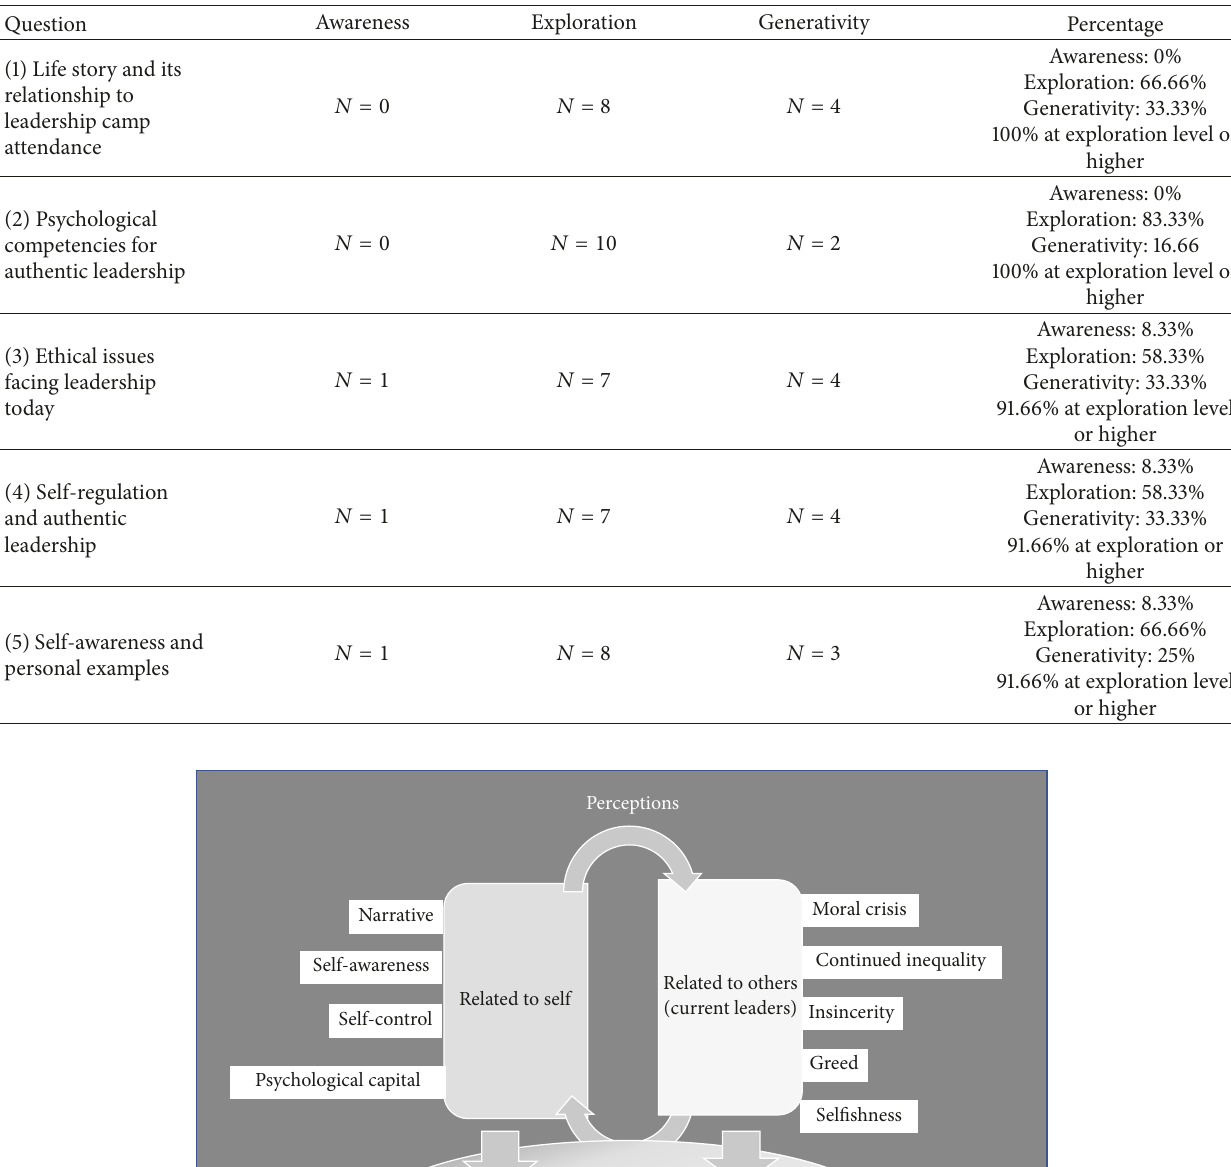
Table 3: Grading rubric of the level of engagement with authentic leadership.